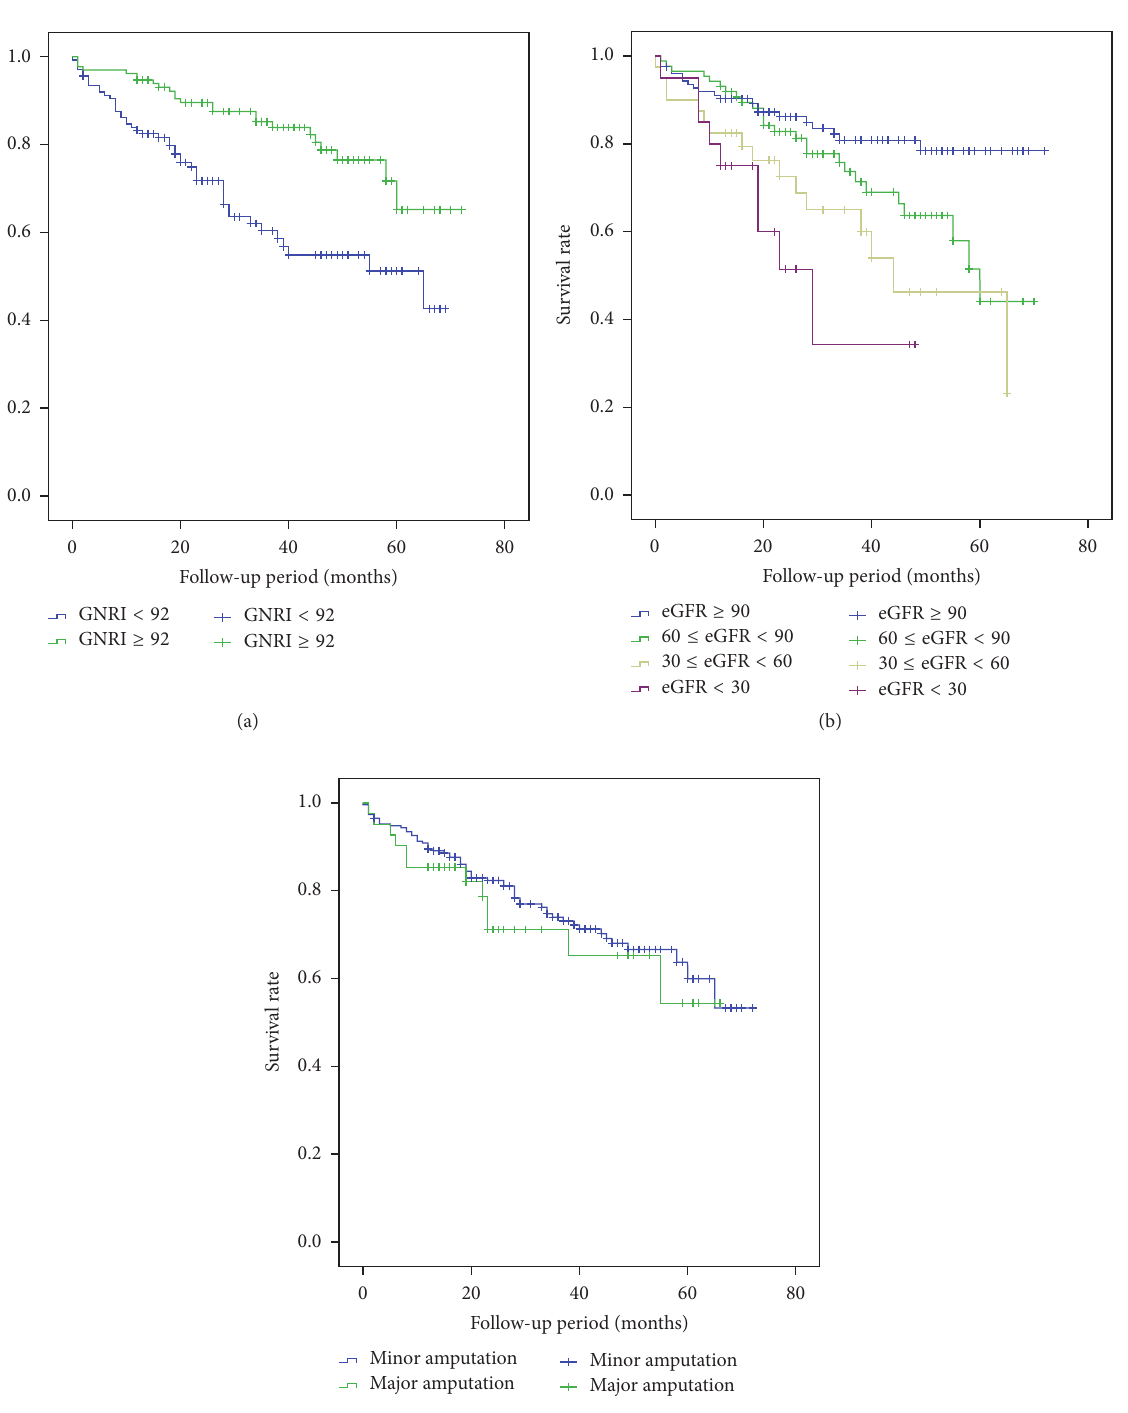
Figure 2: Kaplan-Meier survival curves of the proportion of patients with mortality, according to (a) GNRI categories (low GNRI, < 92; high GNRI, ≥ 92), (b) eGFR stratification (eGFR, ≥ 90; 60 ≤ eGFR < 90; 30 ≤ eGFR < 60; eGFR < 30), or (c) amputation categories (minor amputation; major amputation). The differences between groups in (a) and (b) were significant (log-rank test, all 𝑝 < 0.001 ). There was no significant difference in (c) between groups (log-rank test, 𝑝 = 0.496